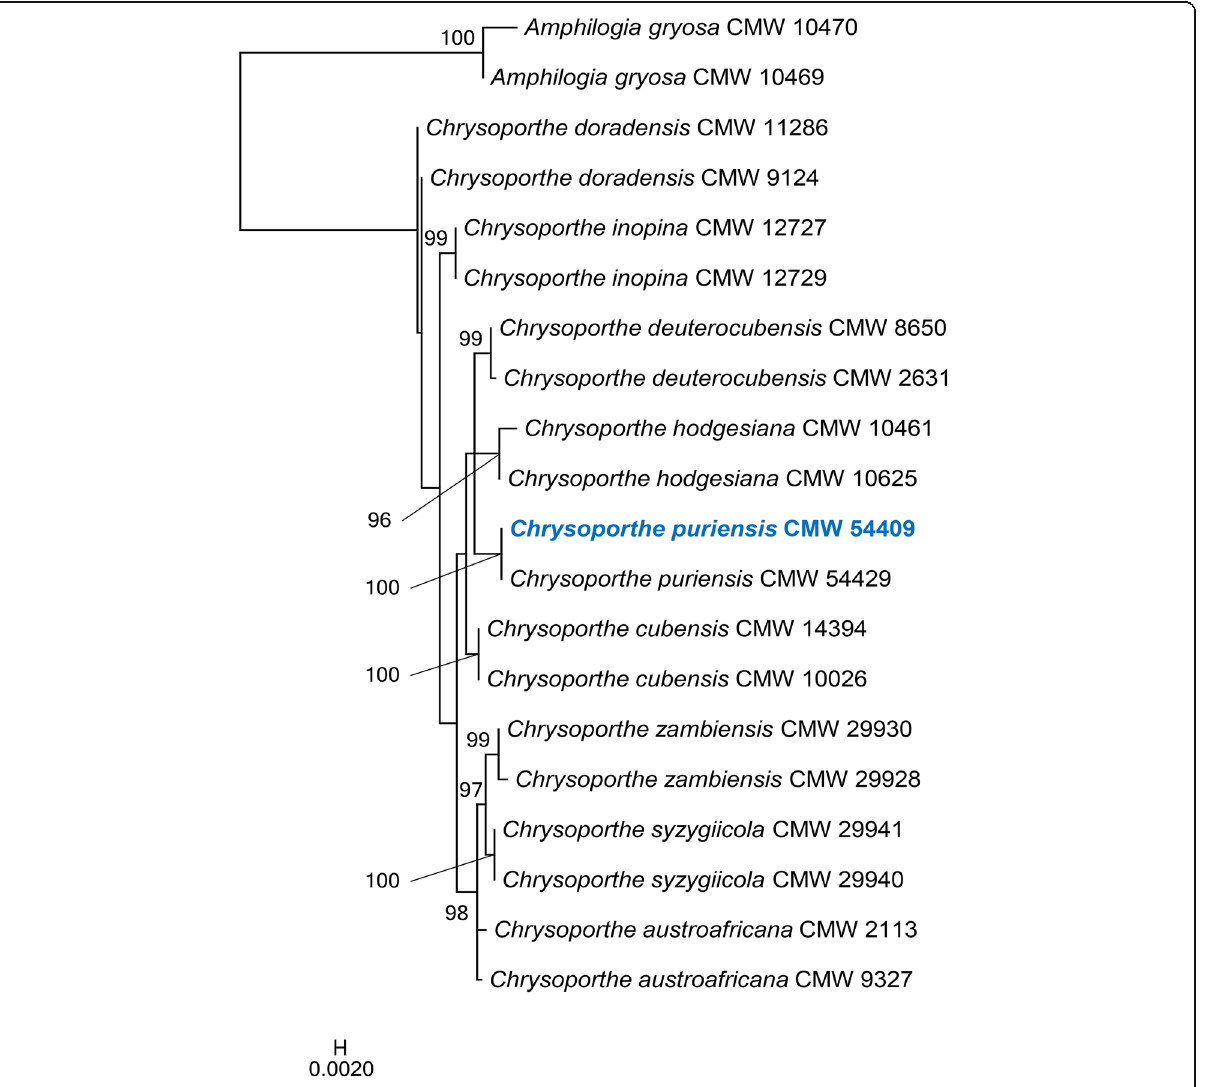
Fig. 4 Maximum Likelihood tree based on ITS region and partial gene sequences of but 1 and but 2. Bootstrap values ≥ 65% are shown. The isolates used in this study are indicated in blue and